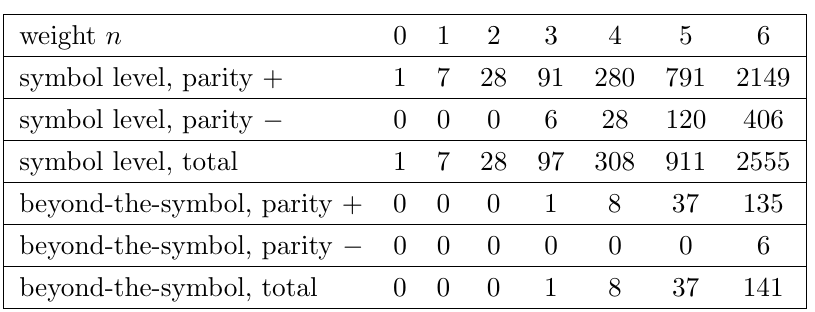
Table 1 . Number of extended Steinmann heptagon functions through weight 6: those already seen at the symbol level, plus the beyond-the-symbol functions, graded by